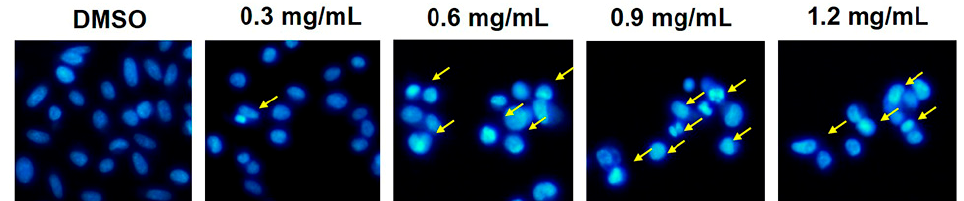
Figure 2. Fragmentation and nuclear condensation were observed by Hoechst 33342 staining. PC-3 cells were treated with stem extract (0, 0.3, 0.6, 0.9, and 1.2 mg/mL) for 24 h. Treated cells exhibited morphological changes in the nuclei typical of apoptosis. Photographs were taken under a fluorescence microscope (20 × ). Arrows represent apoptotic cells.